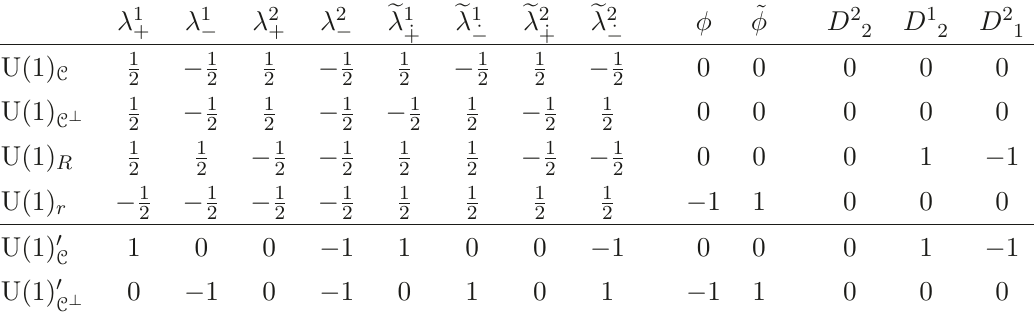
Table 4 . N = 2 vector multiplet; gaugini, scalars, and auxiliary